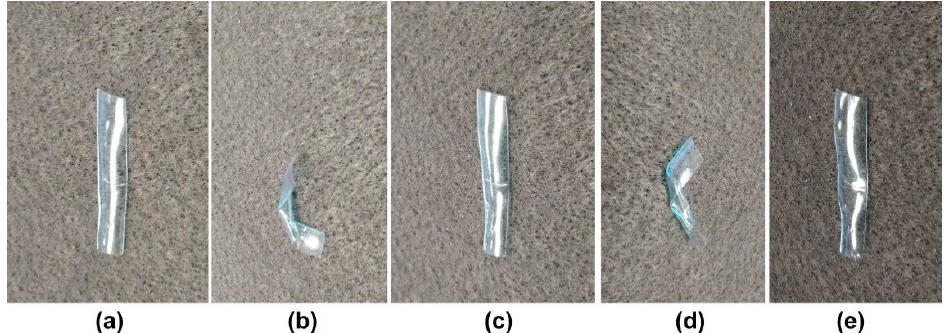
Figure 2. Shape memory effect (SME) in dried Slime. ( a ) Dried Slime; ( b ) After heating and twisting; ( c ) After heating for shape recovery; ( d ) After a second round of heating and twisting; ( e ) After wetting by water droplet, and then drying in air.